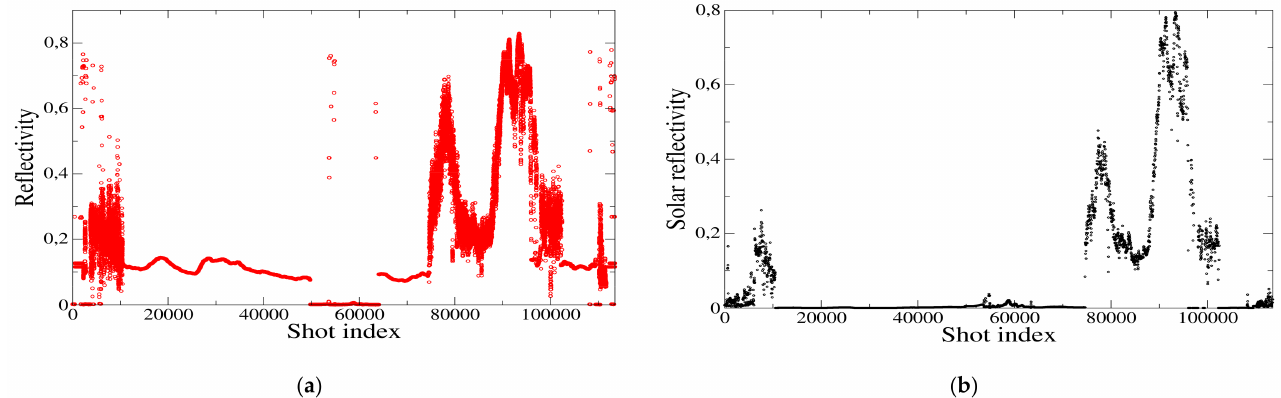
Figure 23. Ground reflectivity from the database used. ( a ) for laser beams (incidence angle close to 0). ( b ): for solar flux (huge incidence angle).